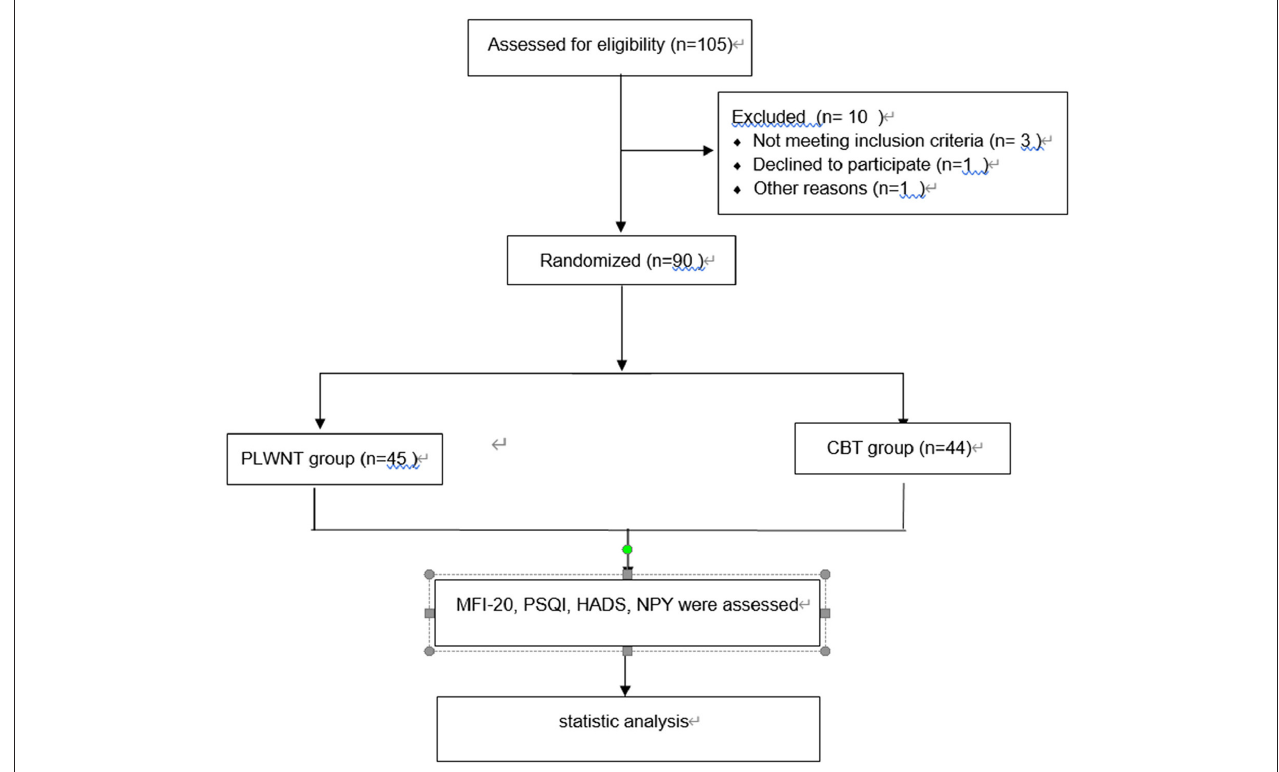
FIGURE 2 | Recruitment